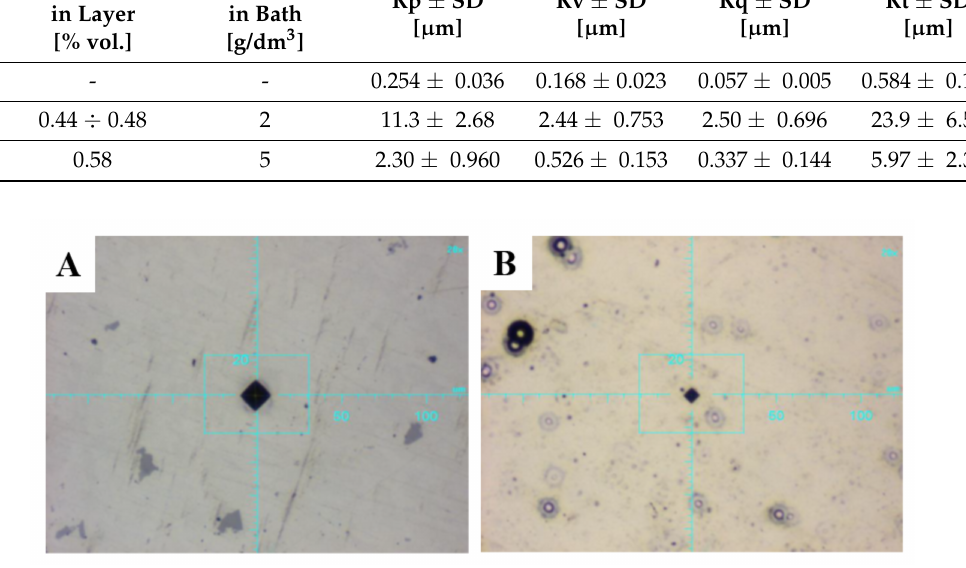
Figure 4. Images of traces on sample surfaces (magnification 20 × ; ( A ) AW-7075; ( B ) Ni-P/Si 3 N 4 ).